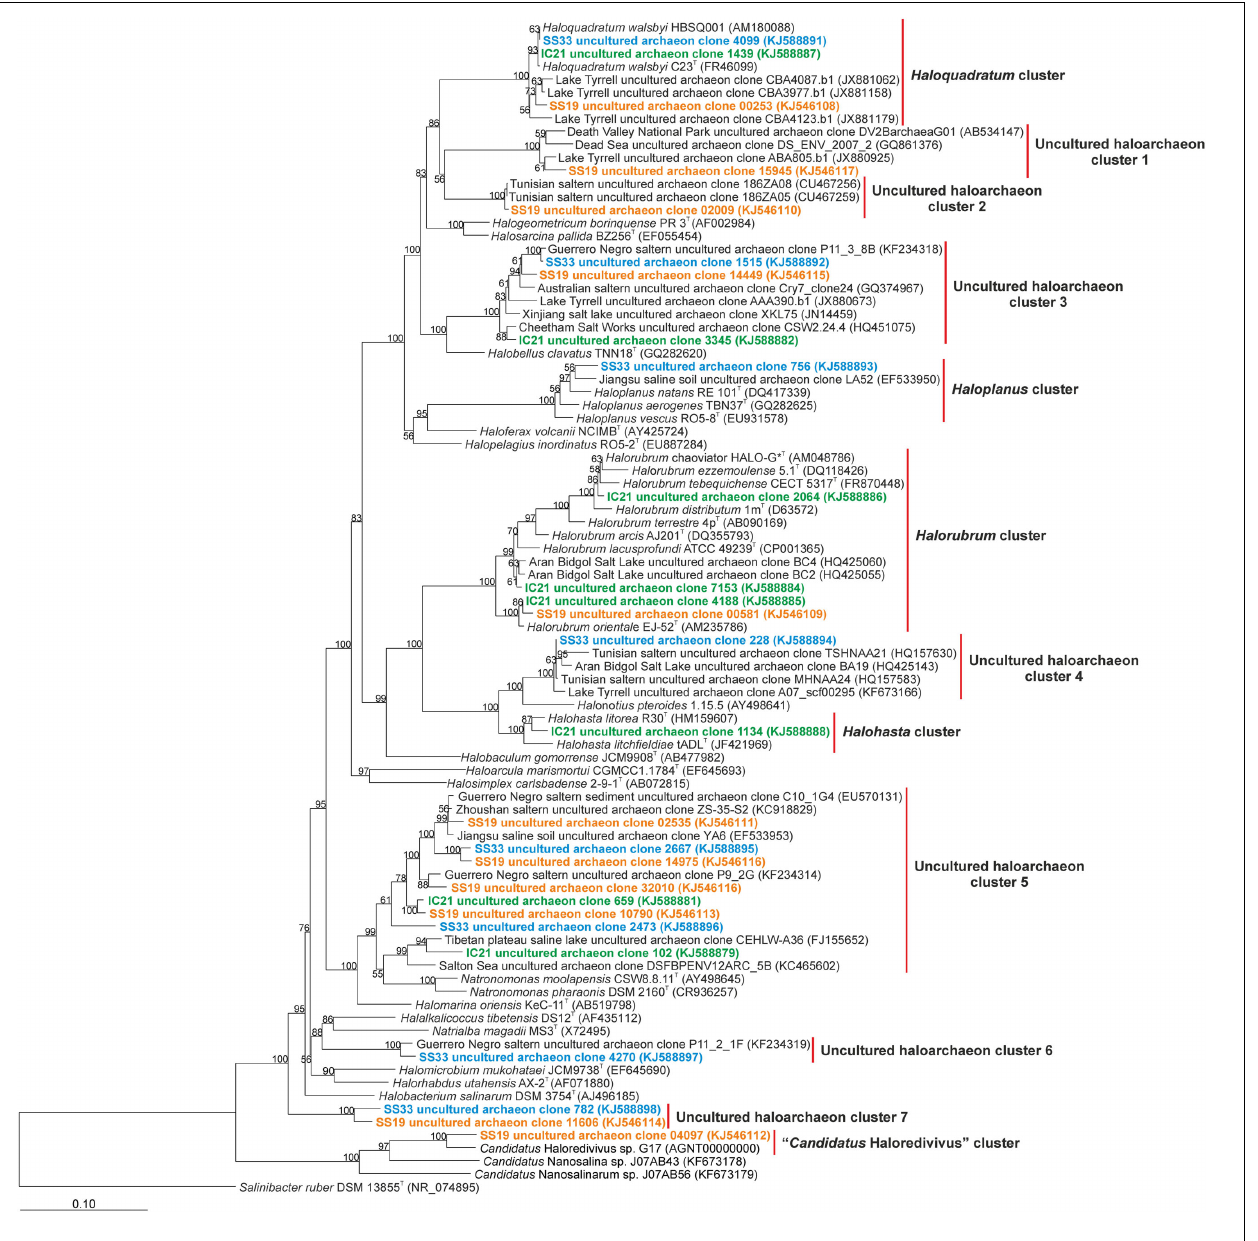
FIGURE 6 | Phylogenetic affiliation of the Euryarchaeaota 16S rRNA reads of the datasets SS19, IC21, and SS33. Phylogenetic reconstruction was conducted by maximum likelihood (RAxML) with near full length (1300 nt) reference 16S rRNA gene sequences from a manually curated alignment